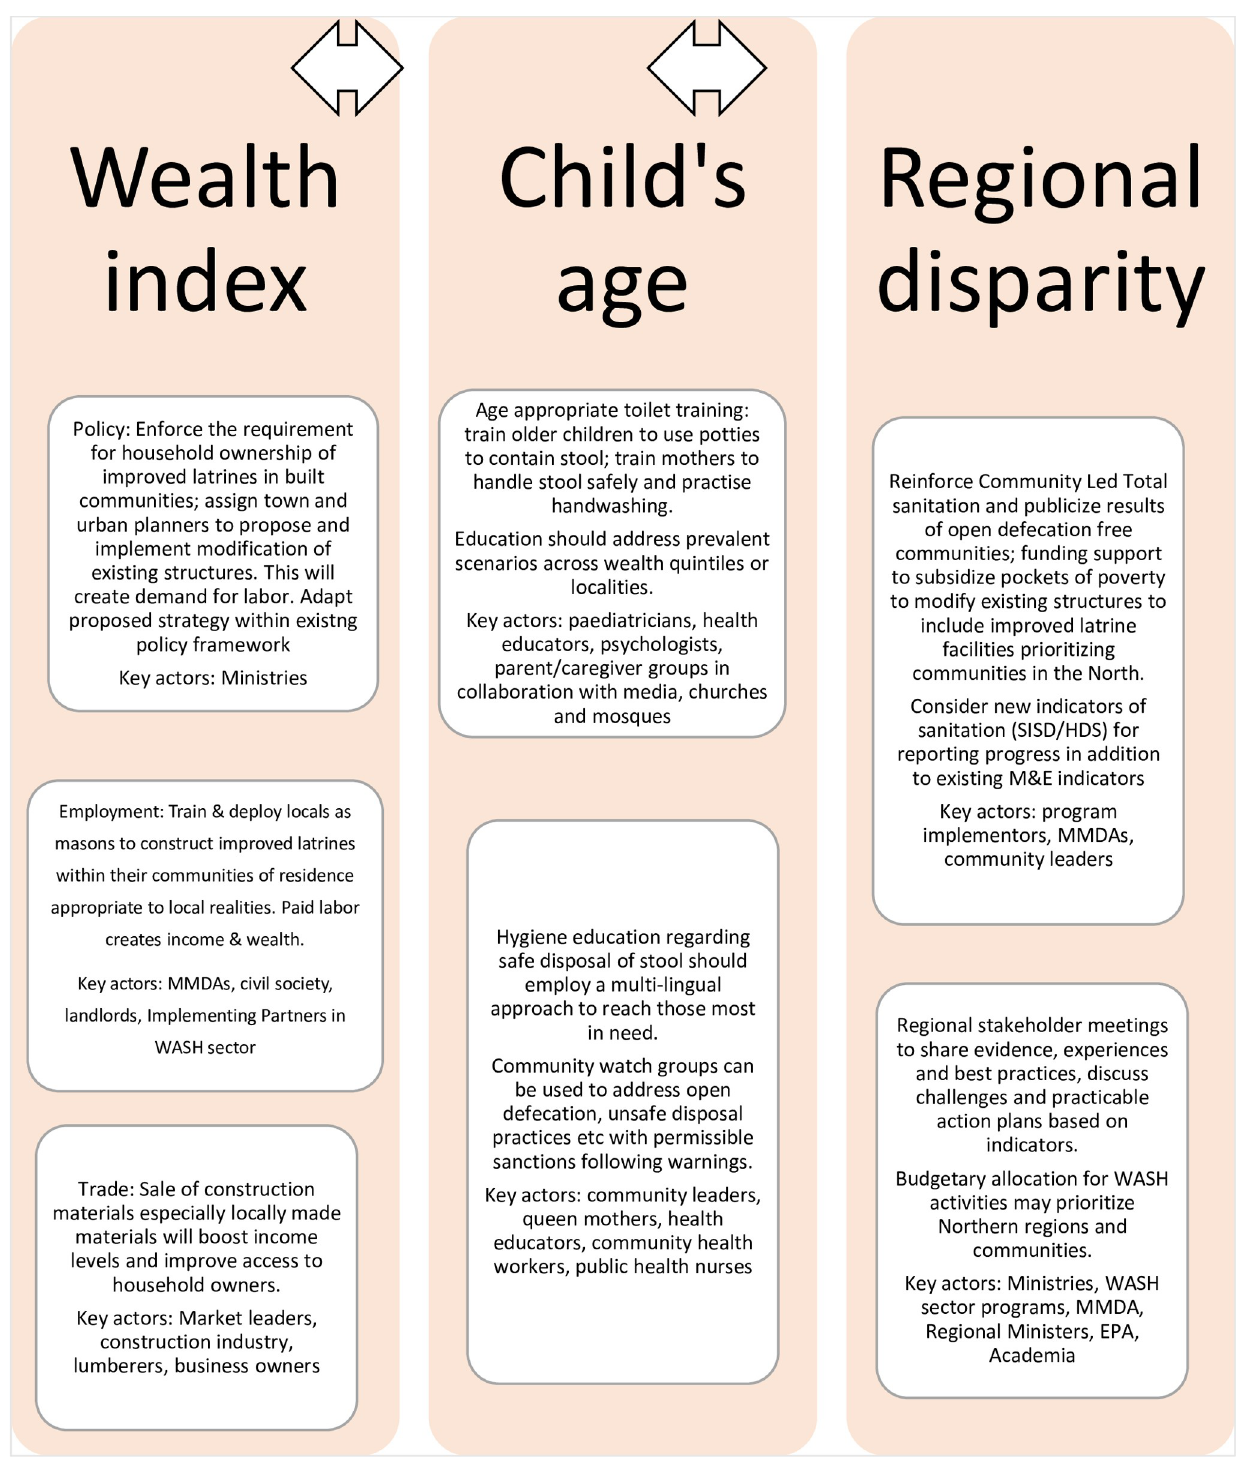
Fig 2. A conceptual framework of a proposed synergy of interventions based on results of the study.